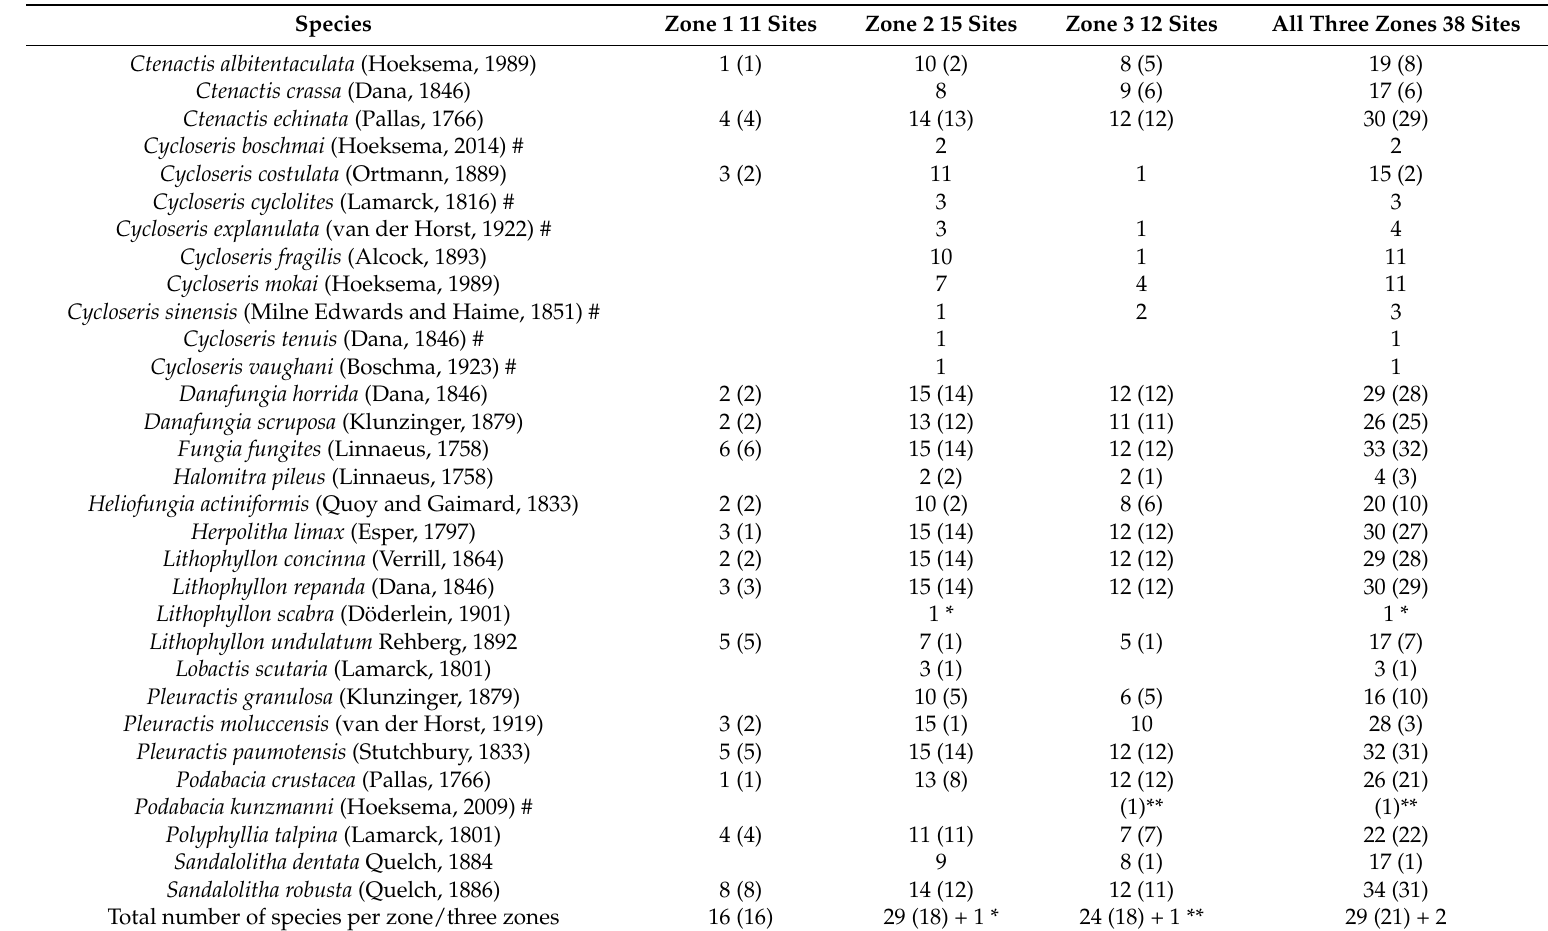
Table 2. Numbers of mushroom coral species ( n = 31) encountered off Jakarta: 29 species recorded in 2005 and two additional ones observed in 1983 and 1995; # = new species record for the area. Shallow-water records (if any) are indicated by